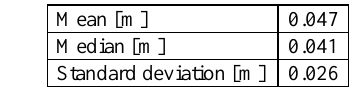
Table 1. Statistic values of set of distances.